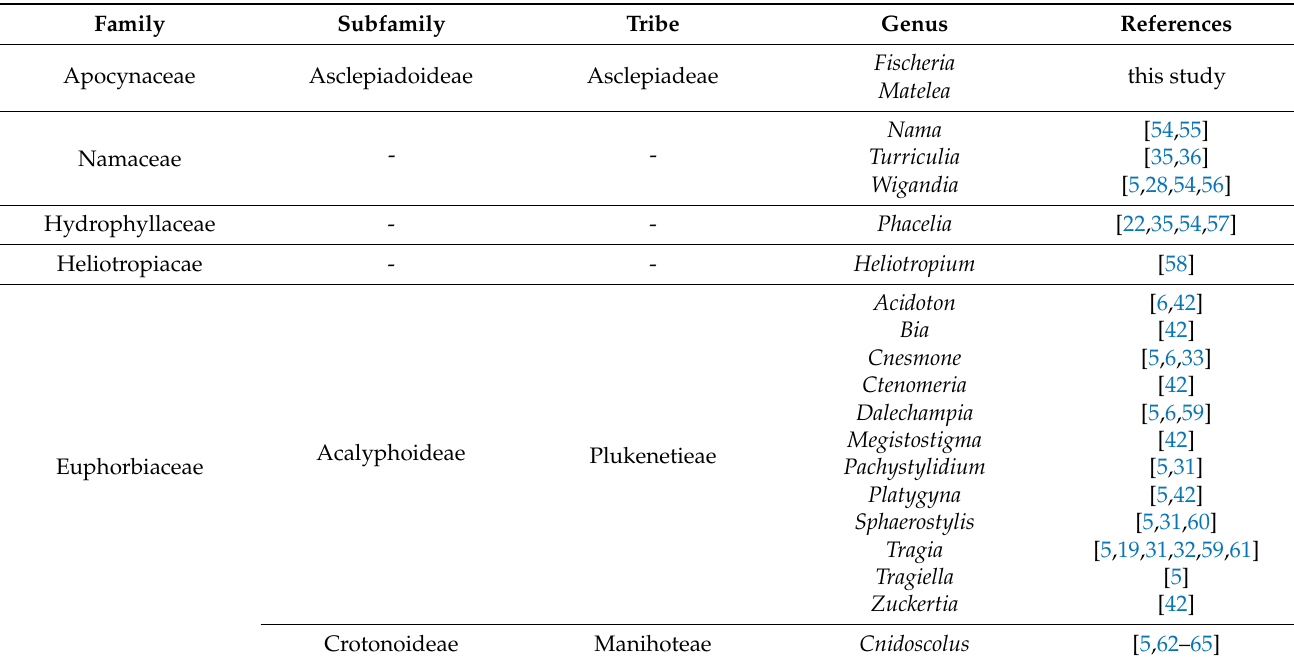
Table 2. Distribution of stinging trichomes in